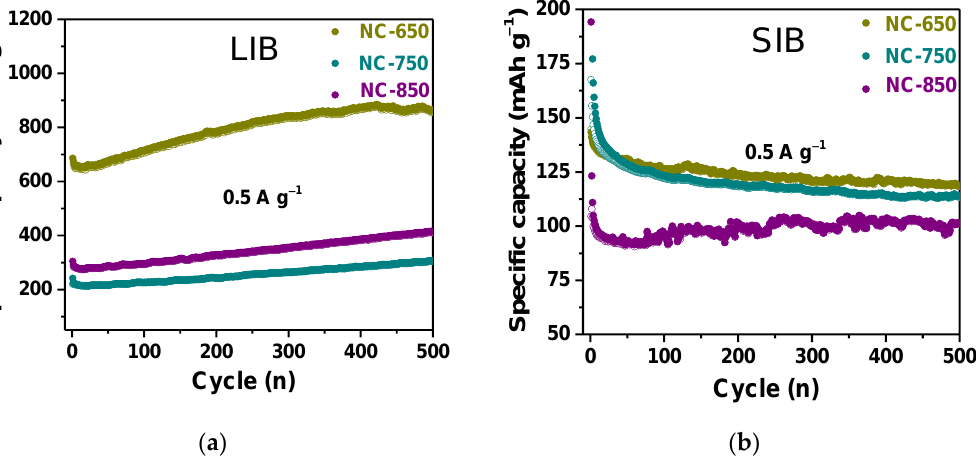
Figure 7. Long-term cycling curves at 0.5 A·g −1 for NC-650, NC-750, and NC-850 in ( a ) lithium-ion batteries and ( b ) sodium-ion batteries.